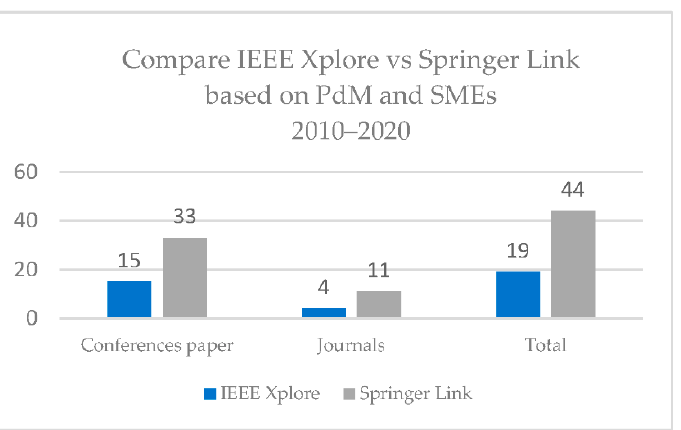
Figure 4. Compare IEEE Xplore vs. Springer Link Studies based on PdM and ML methods.